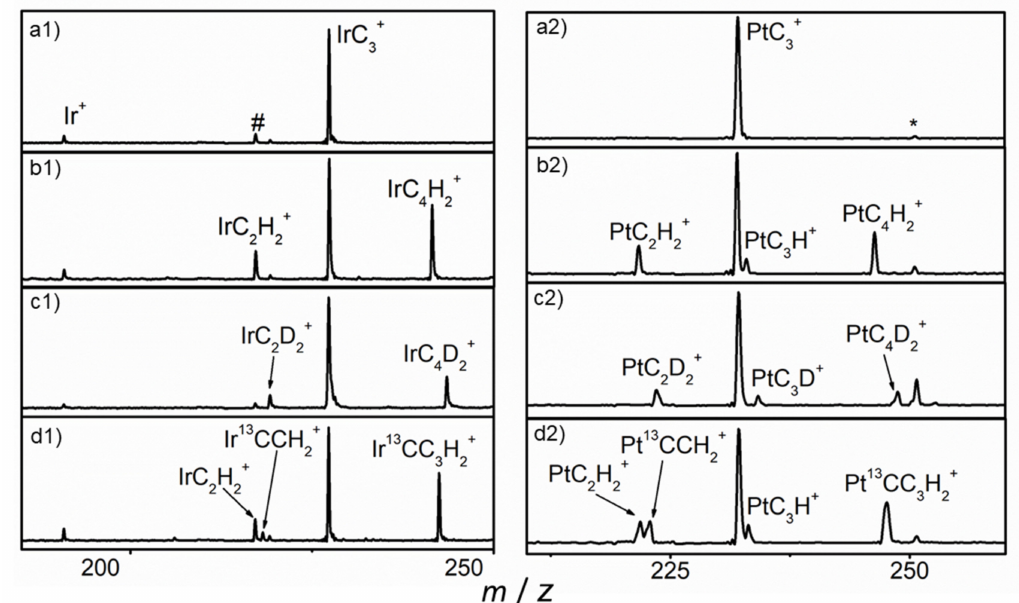
Figure 1. Mass spectra from the reactions of M C 3+ ( M = Pt and Ir) with He ( a1 , a2 ), CH 4 ( b1 , b2 ), CD 4 ( c1 , c2 ) and 13 CH 4 ( d1 , d2 ). # and * denote IrCO + and PtC 3 H 2 O +